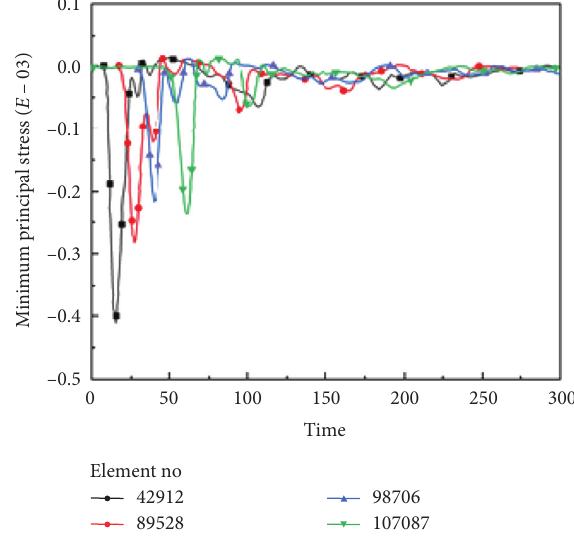
Figure 9: Curve of minimum principal stress-time on selected